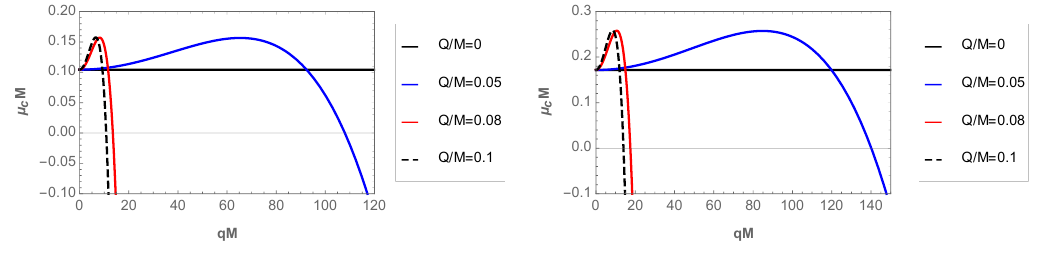
Figure 6 . The behaviour of the critical scalar field mass µ c M as a function of qM , with Λ M 2 = 0 . 01 (left panel), Λ M 2 = 0 . 04 (right panel).